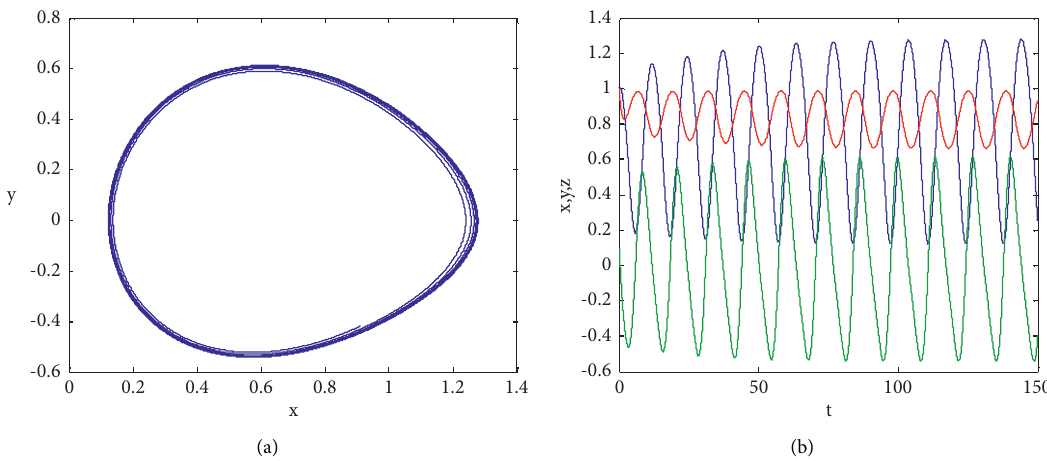
Figure 2: (a) Phase diagram of system (3). (b) The evolution of the state variables with time.